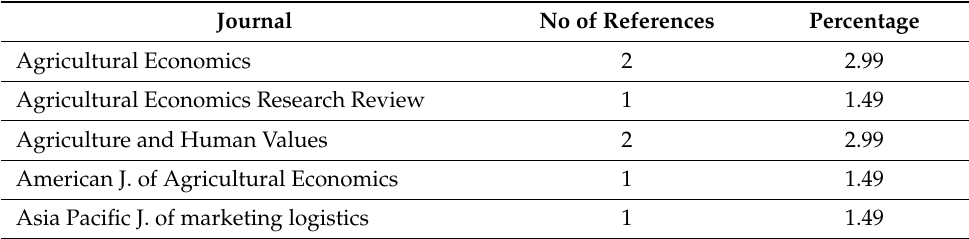
Table 3. Number of Articles across journals, Source: The Authors. Journal No of